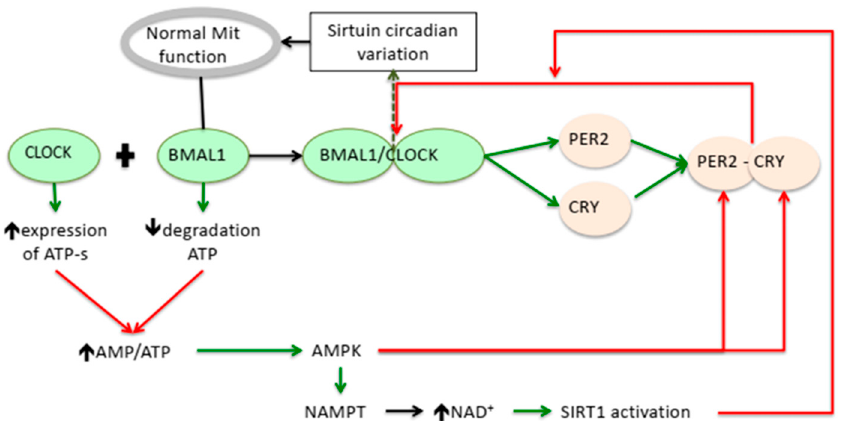
Figure 1. Putative relation between circadian genes regulation and modulators of the oxidative stress. On one side, BMAL1 and CLOCK regulate the mitochondrial function and increases the AMP/ATP ratio. On the other side, the circadian expression of BMAL1 and CLOCK genes is regulated by adenosine monophosphate activated protein kinase acting on the PER-2-CRY expression and indirectly by activating sirtuin 1. Legend: BMAL-1: Brain- and muscle ANRT-like protein-1; CLOCK: Circadian Locomotor Output Cycles Kaput; PER2: period circadian regulator 2; CRY: cryptochromes; Mit: mitochondria; ATP-s: ATP-synthase; AMP: Adenosine monophosphate; ATP: Adenosine triphosphate; AMP-kinase: adenosine monophosphate activated protein kinase; NAD: Nicotinamide adenine dinucleotide; NAMPT: nicotinamide phosphoryl-transferase; SIRT1: